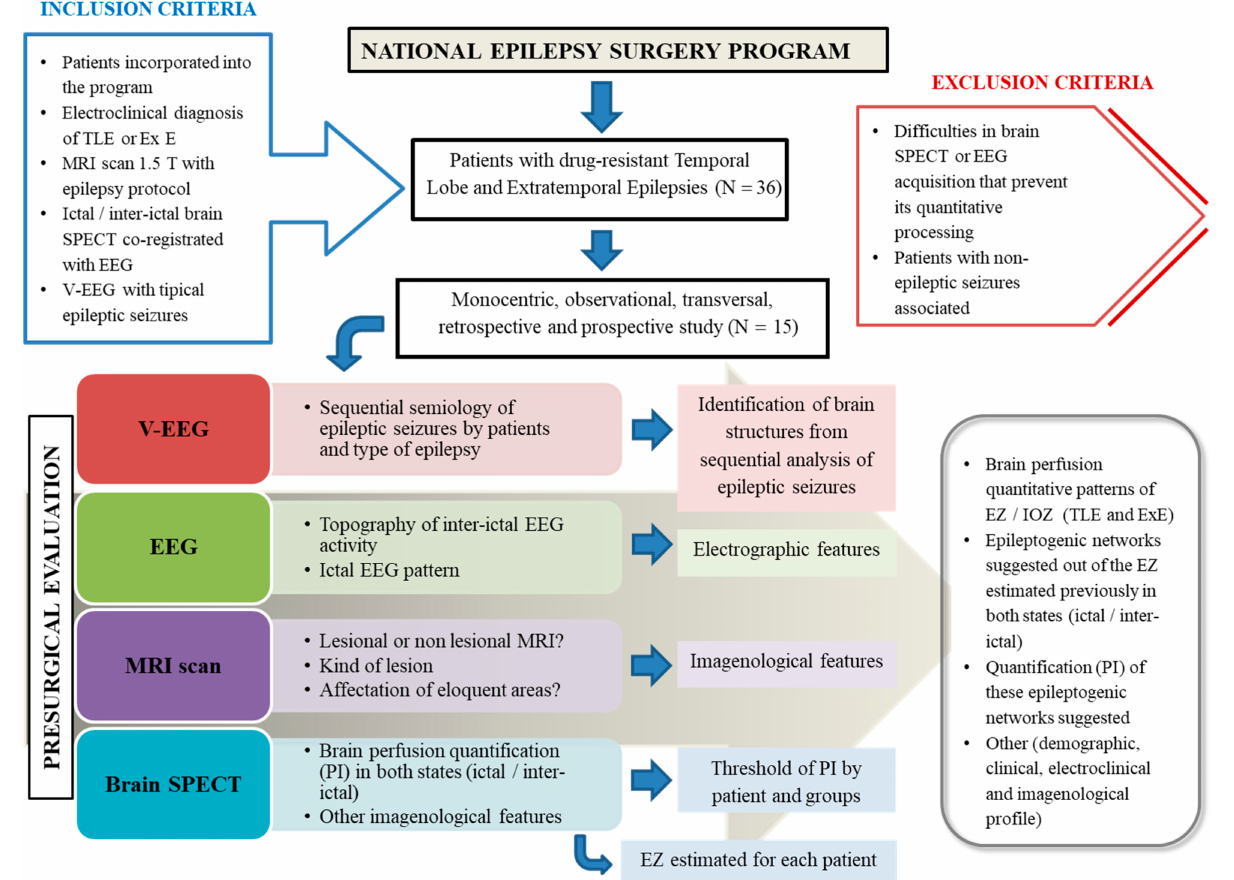
Figure 1. General methodological setting of this study. TLE (temporal lobe epilepsy), Ex E (extratem- poral epilepsy), MRI (Magnetic Resonance Imaging), SPECT (Single-Photon Emission Computed Tomography), EEG (electroencephalography), V-EEG (Video-Electroencephalography), EZ (epilepto- genic zone), IOZ (ictal onset